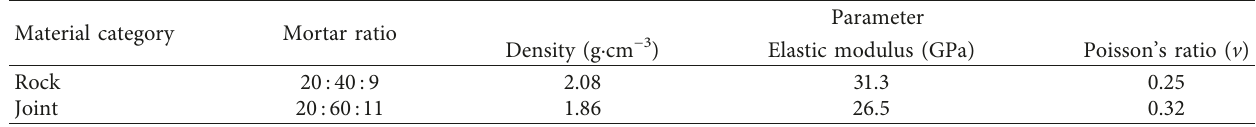
Figure 1: The design figure of two thickness filler joint test pieces: (a) 4mm and (b) 10mm. Table 1: Mechanical parameters of the simulated rock and